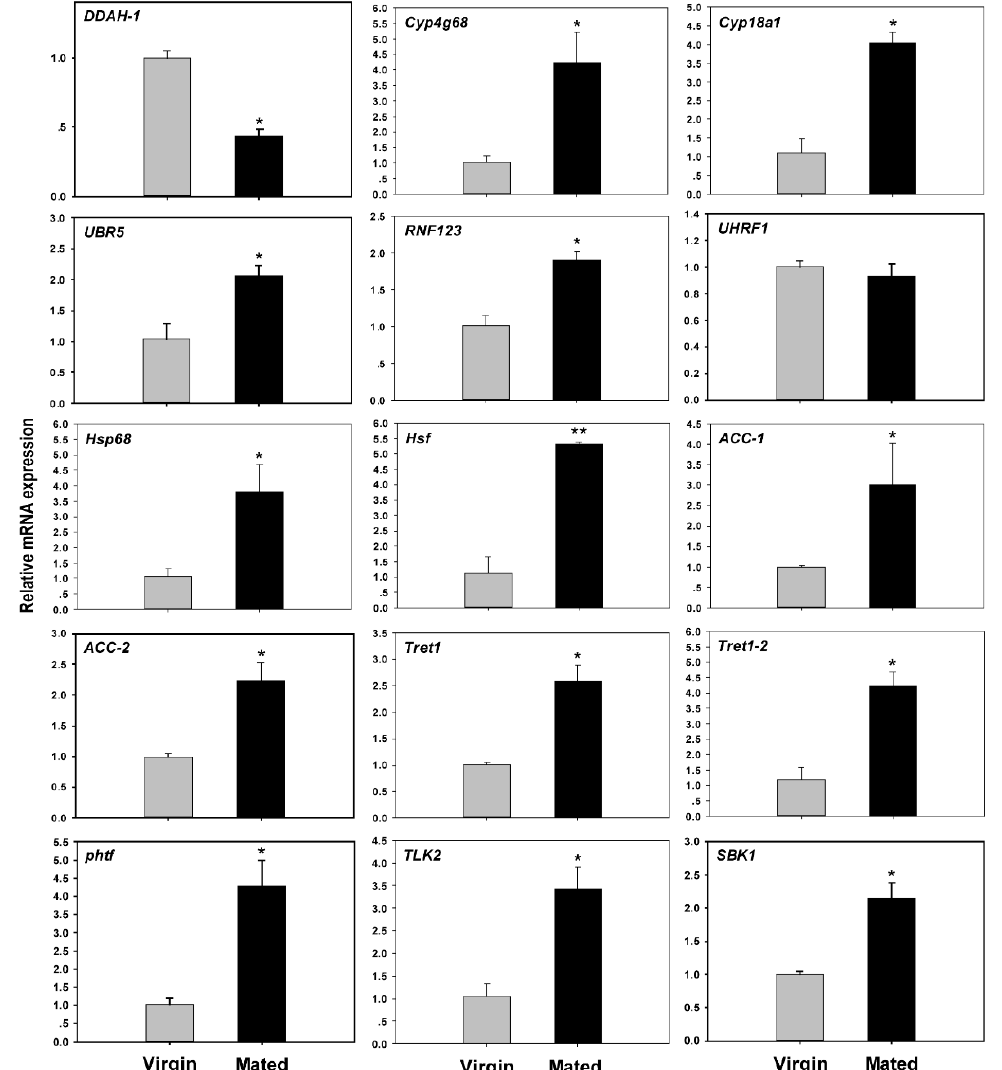
Figure 4. Expression profile of transcripts that are differentially expressed between mated and virgin B. tabaci females by RT-qPCR. Mean expression levels (± SEM) of selected genes in virgin females (grey bars) and mated females (black bars). * p < 0.05; ** p < 0.01.